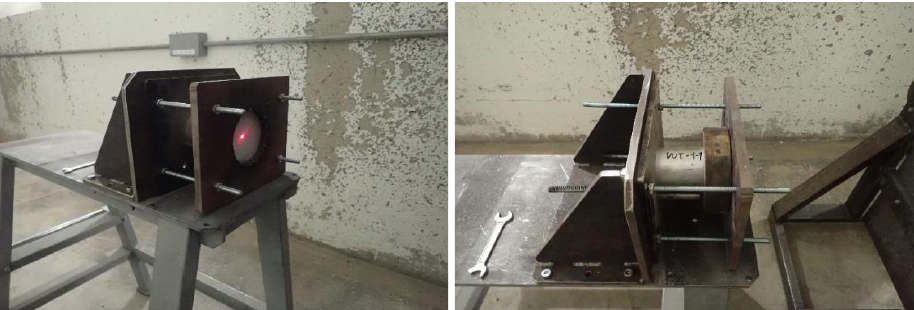
Fig. 2 Firing stand with test target Table 2. Results of projectile penetration